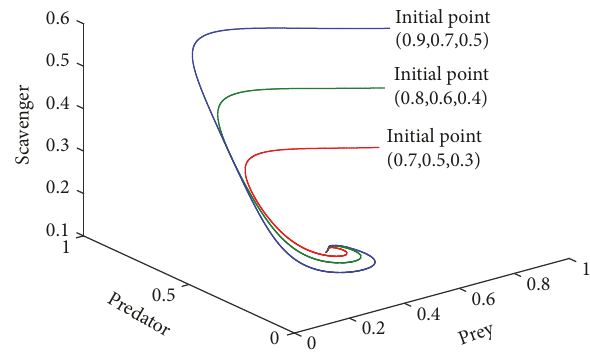
Figure 1: The phase portrait of system (3) using data